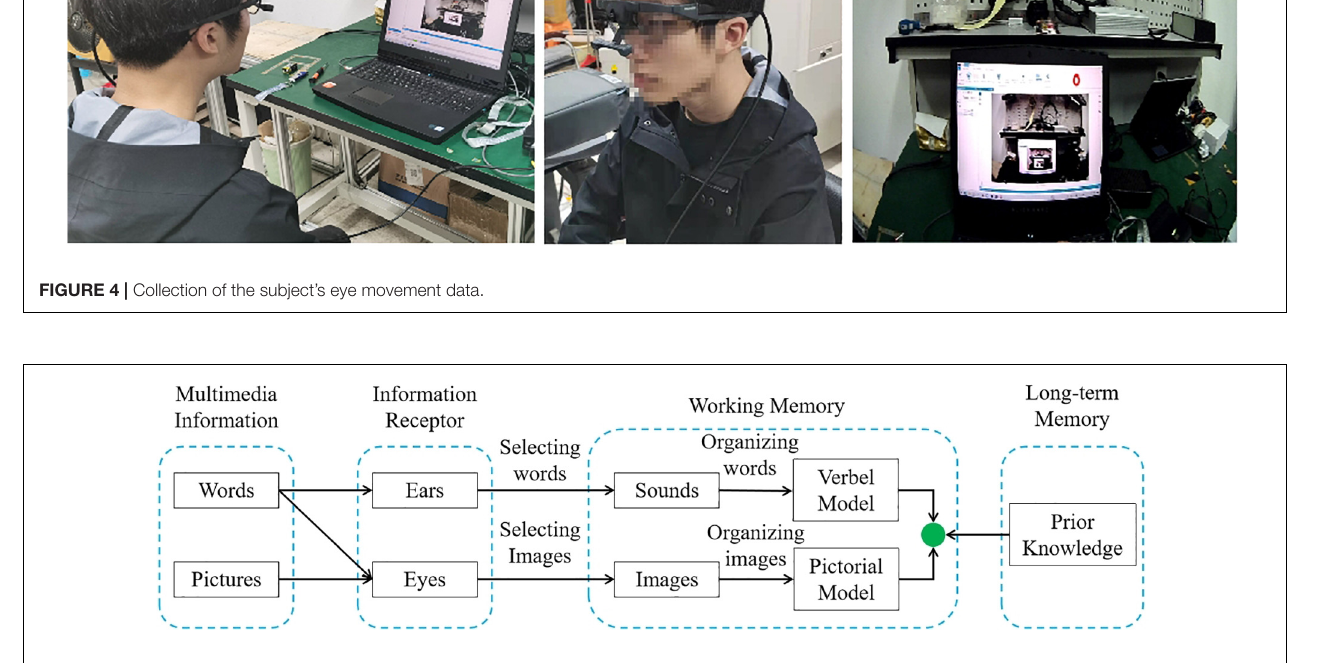
FIGURE 5 | Schematic of multimedia cognitive theory.